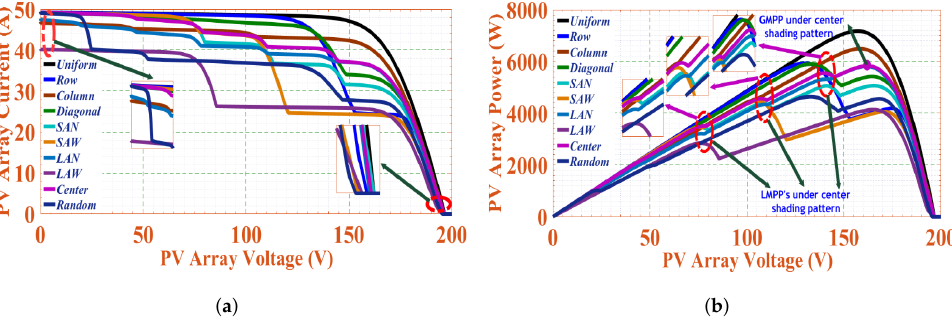
Figure 11. S-P-T-C-T topology results under various PSCs. ( a ) I-V characteristics, ( b ) P-V characteristics.